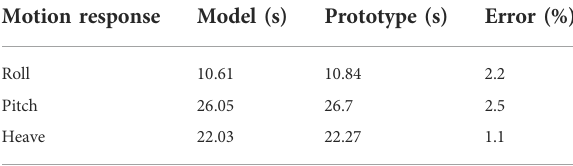
model is only 0.5 mm in order not to affect the center of gravity of the fl oating offshore wind turbine. The physical model is shown in Figure 4. The speci fi c parameters of the fl oating offshore wind turbine are shown in Table 3. Figure 5 is the diagram of connection scheme. The beam and the small buoy use the steel structure to connect with each other by interpolation method, and the steel structure is fi xed on the small buoy. The model buoys are hollow, where can set the solid pressure load to balance the fl oating offshore wind turbine.